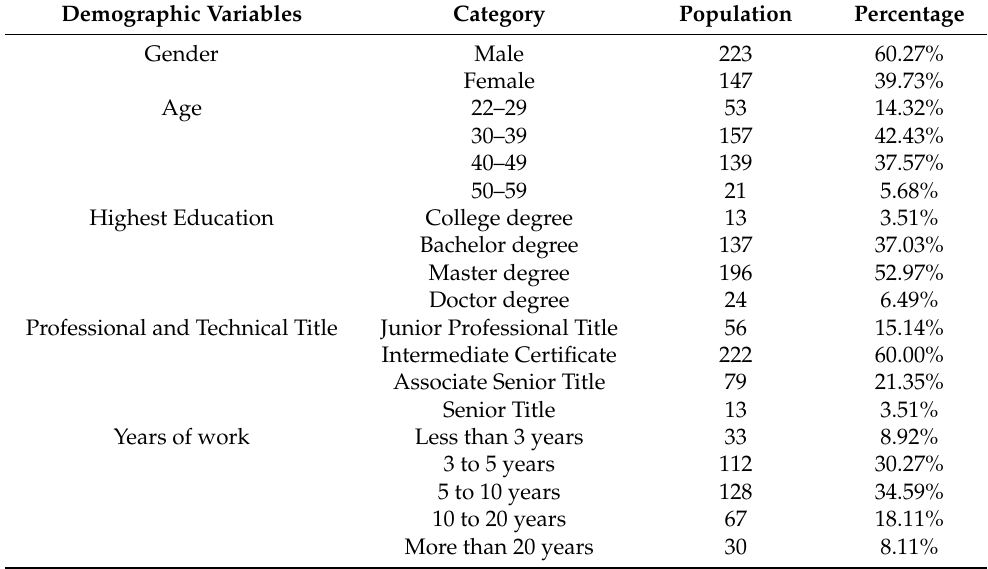
Table 1. Demographic information of the